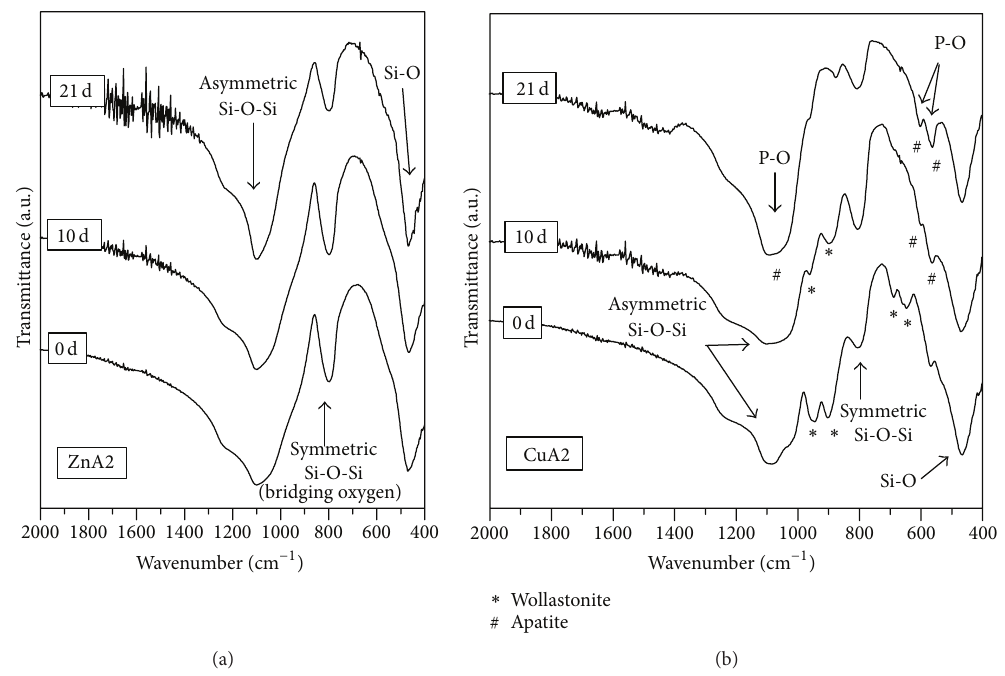
Figure 6: FTIR spectra of (a) ZnA2 and (b) CuA2 glass-ceramic scaffolds before and after immersion in SBF solution for 10 and 21